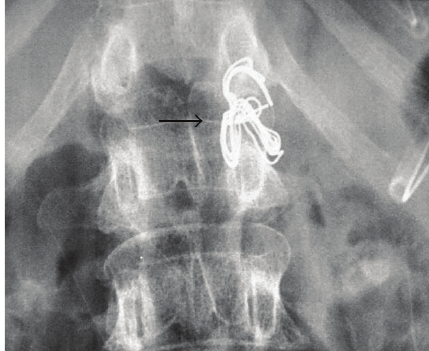
Figure 2: Magnified image showing swab between T12 and L1 vertebral levels (arrow).